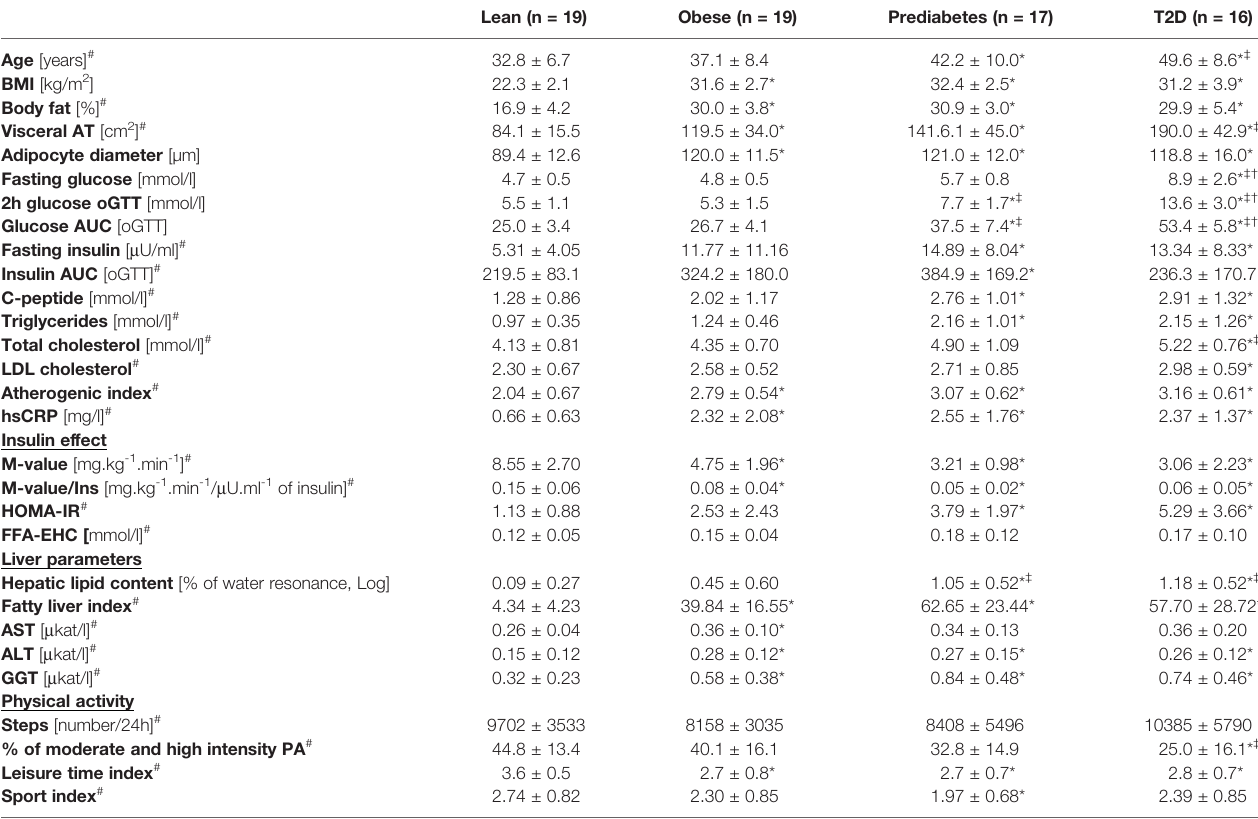
TABLE 1 | Characteristics of the study population (Study